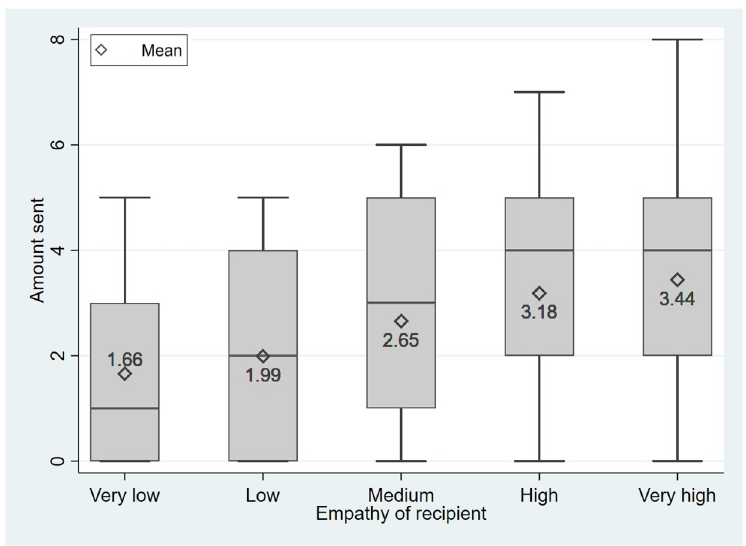
Fig 4. Boxplot of prosocial behavior conditional on the empathy of the